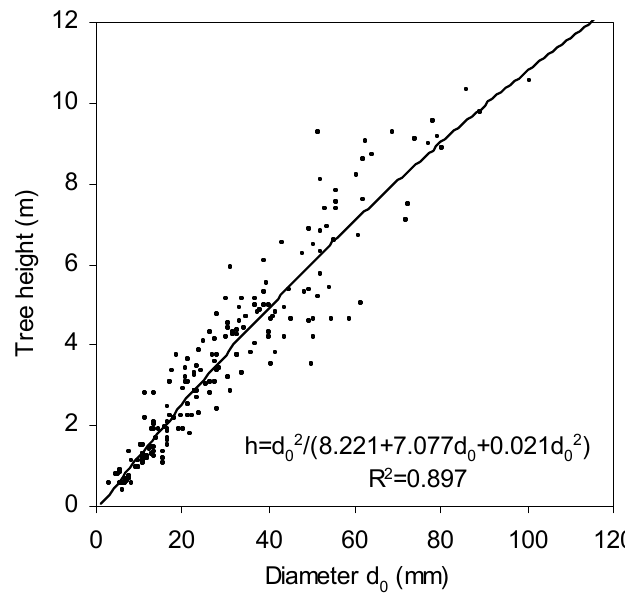
Figure 2. Relationship between d 0 stem base diameter and tree height derived from the sampled common aspen trees (values of SE were 11.812, 0.693, and 0.009, and the p -values 0.487, < 0.001, and 0.017 for parameters b 1 , b 2 , and b 3 , respectively; MSE = 0.612). Table 3. Descriptive statistics of the sampled common aspen trees.